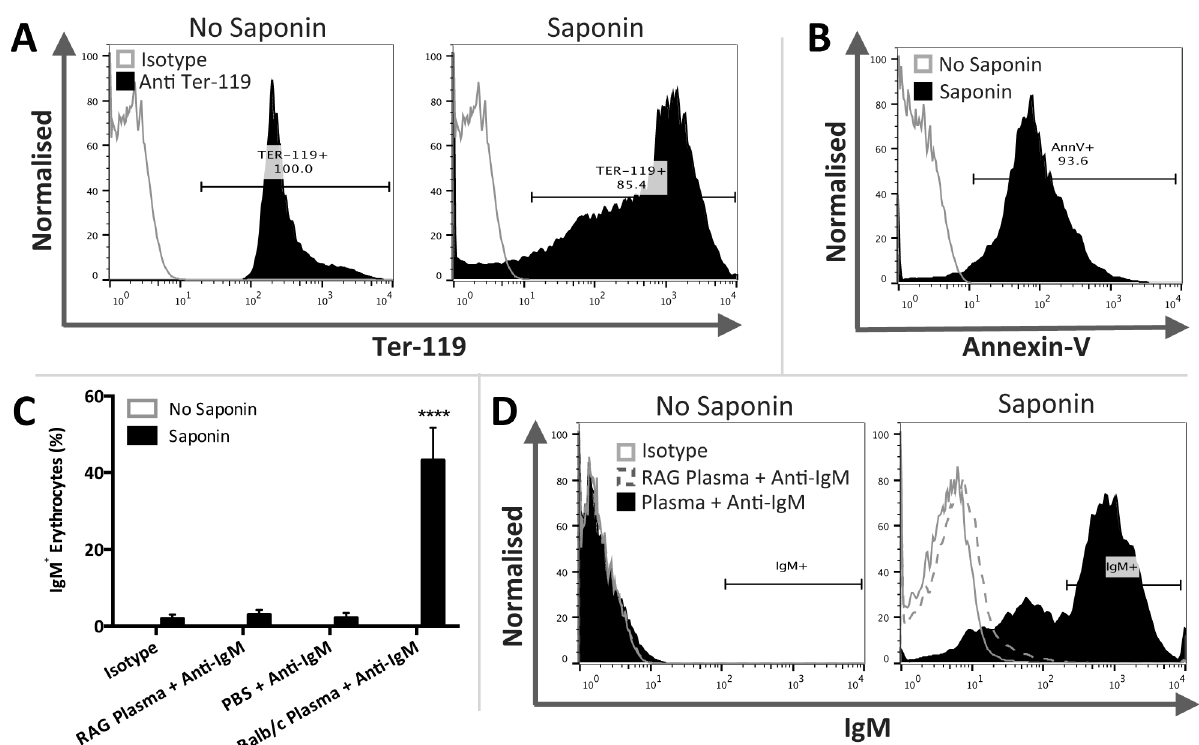
Fig 6. IgM binds permeabilised mouse erythrocytes. Mouse erythrocytes were stained with erythrocyte marker Ter-119 prior to permeabilisation with saponin. Annexin-V (AnnV) staining was used to confirm permeability. Non-permeable and permeable erythrocytes were then exposed to either mouse IgM isotype control antibodies, PBS, Balb/c plasma (as a source of IgM) or plasma from immunodeficient RAG1-deficient mice. Staining was assessed by flow cytometry. A ) Both non-permeable and permeable erythrocytes were identified and gated on the basis of Ter-119 positivity. B ) Permeable Ter-119 + erythrocytes demonstrated a distinct shift in AnnV positivity indicating successful permeabilisation. C ) Non-permeable and permeable erythrocytes were gated on the basis of Ter-119 positivity and the percentage of IgM + erythrocytes was assessed. IgM binding to non-permeable and permeable erythrocytes in isotype, RAG1-deficient mice plasma and PBS treatment groups remained non-significant. Permeable erythrocytes exposed to Balb/c plasma exhibited significant binding (two-way ANOVA; P < 0.0001; n = 4 per group). D ) Representative histograms illustrating IgM binding to non-permeable and permeable Ter-119 + erythrocytes within the treatment groups. Data expressed as means ±